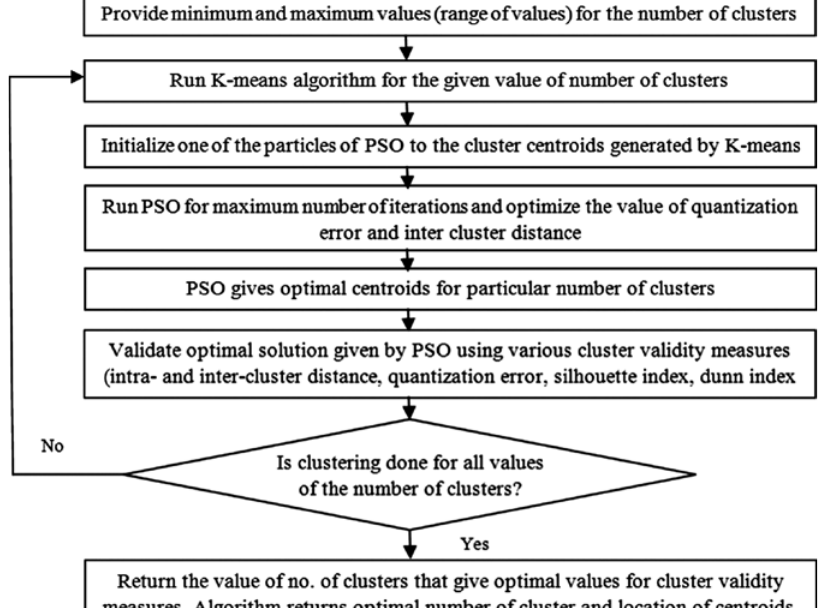
Figure 1: Flowchart of the Proposed